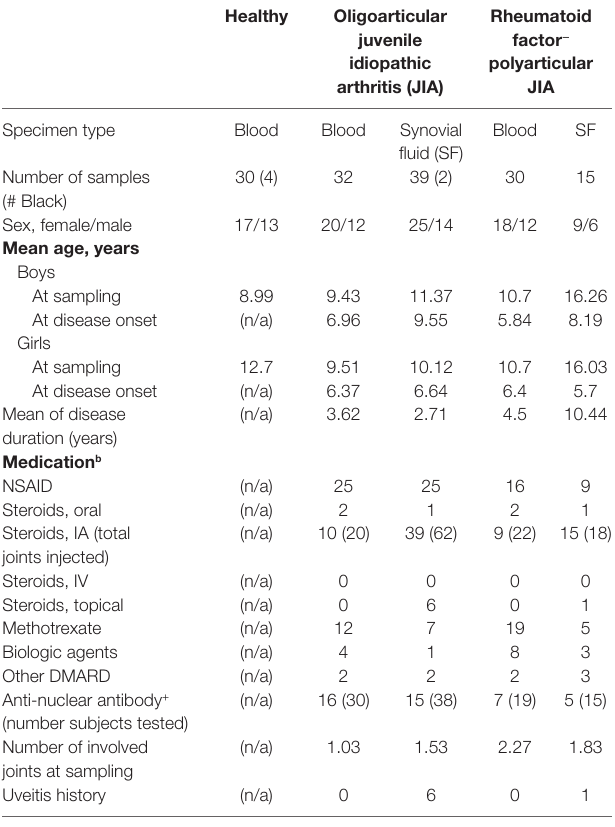
TaBle 1 | Characteristics of study cohort a